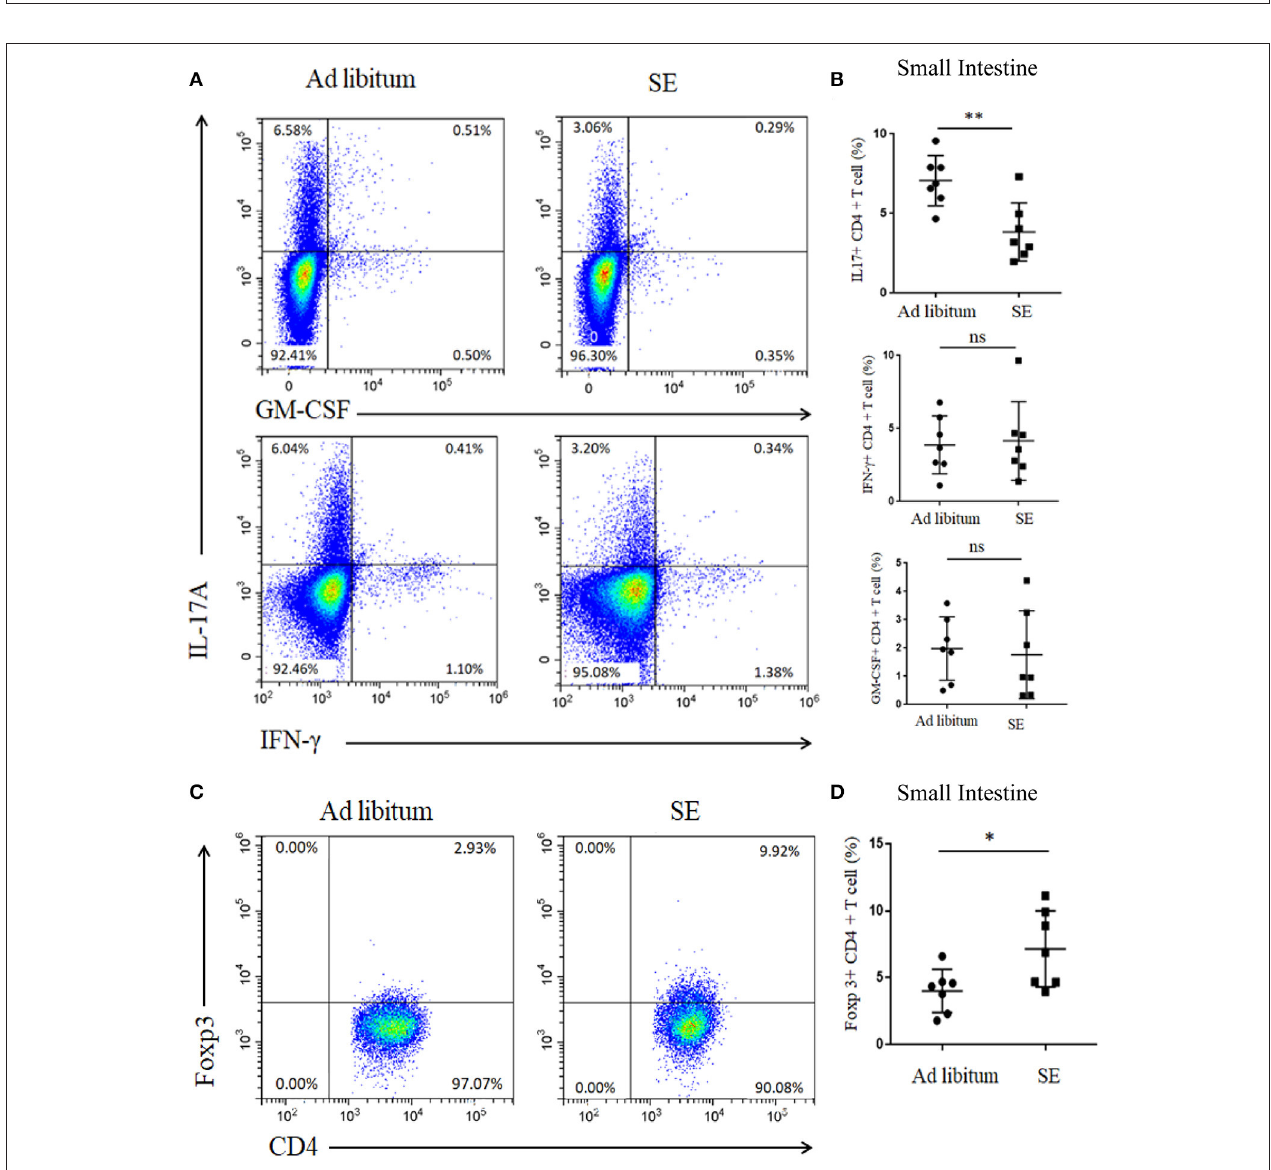
FIGURE 5 | Reduced proportion of IL-17T cells and increased proportion of Tregs in the small intestine lamina propria after 4 weeks of strength exercise (T2). Lymphocytes from small intestine lamina propria were isolated after 4 weeks of SE without immunization and used for assessment of different CD4 T-cell subsets. (A,C) Representative staining of different CD4 T-cell subsets in inguinal lymph nodes (LN), gated on TCR β + CD4 + . (B,D) Statistical analysis of the percentages of CD4 + T cells producing IL-17A, IFN- γ , GM-CSF, and Foxp3. Each dot represents a mouse, and the bars are mean ± SD. * p < 0.05; ** p < 0.005; ns, no significance. All p -values were calculated by Mann–Whitney